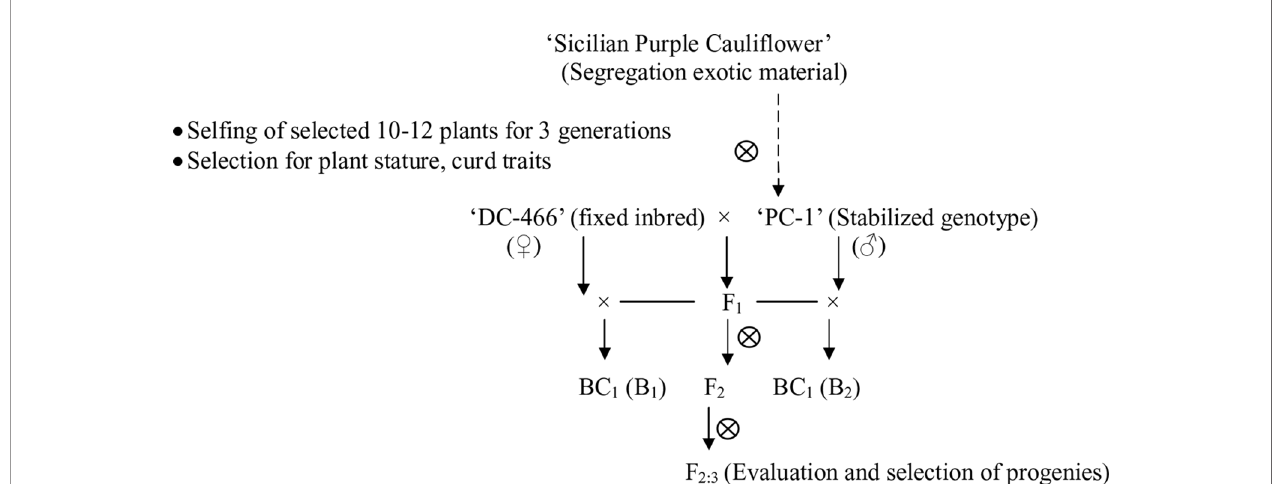
FIGURE 2 | Population development procedure used in the